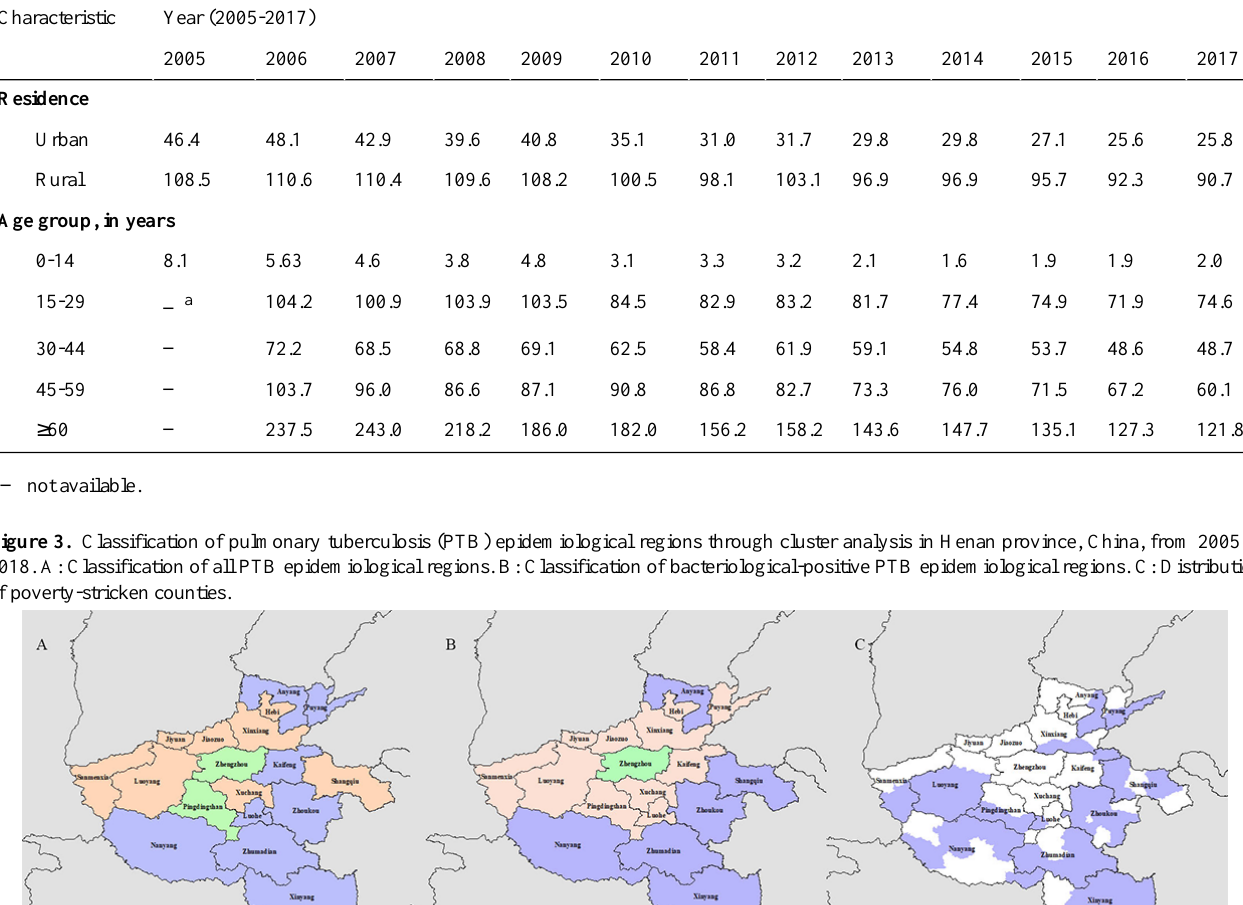
Table 2. Incidence of pulmonary tuberculosis (PTB) cases by age group and residence in Henan province, China, from 2005 to 2017.